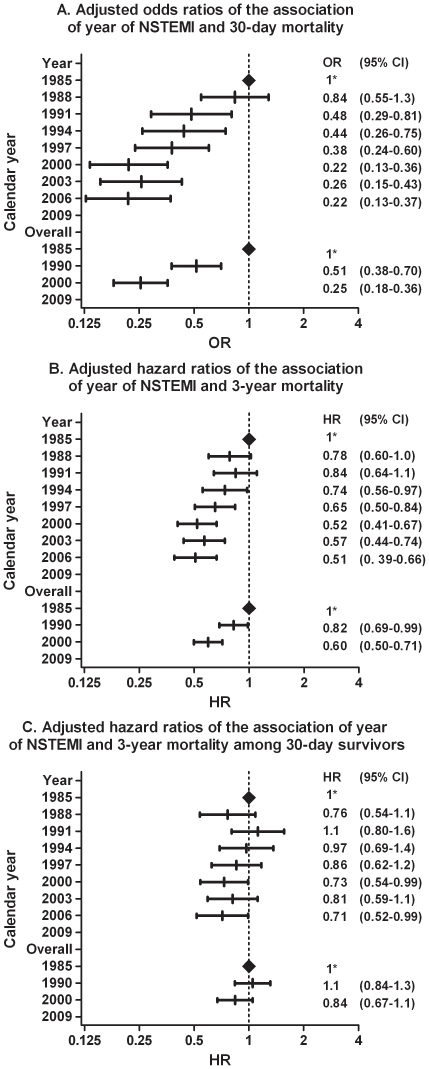
Adjusted odds or hazard ratios of secular trends in mortality after NSTEMI at 30- days (Figure 5A), at 3-year (Figure 5B), and at 3-year among 30-day survivors (Figure 5C).The upper part of the figures compares changes in mortality in time periods of three year, the lower part among patients hospitalised between 1985–1990; 1990–2000; and 2000–2008 *Reference category for the subsequent ratios CI, confidence interval; NSTEMI, non-ST-elevation myocardial infarction; HR, Hazard ratio; OR, Odds ratio